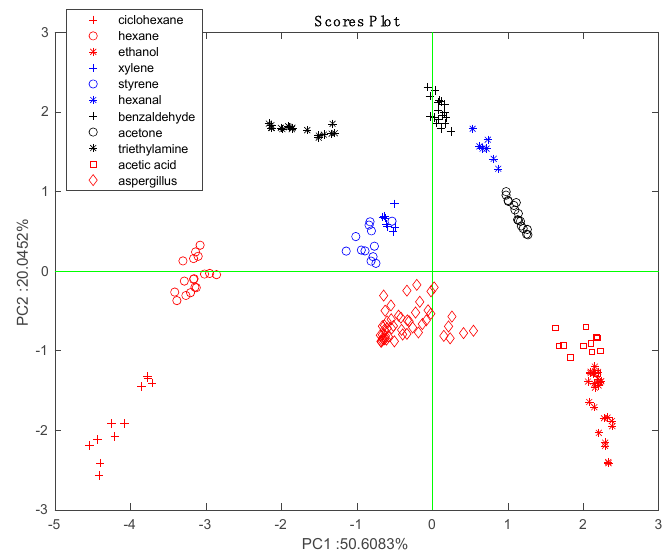
Figure 6. Sensors’ data related to Aspergillus headspaces were normalized and projected onto the scores plot of the PCA calculated with the characterization data and shown in Figure 2. Microorganisms’ data form a close cluster between aromatics and polar compounds.